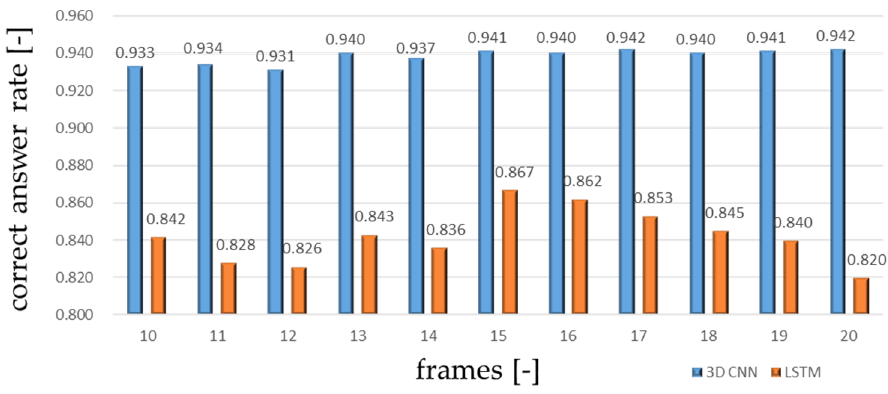
Figure 12. Correct answer rates of LSTM network and 3D CNN for each frame number.